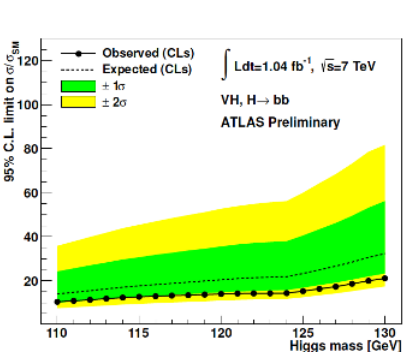
Fig. 2. Expected (dashed) and observed (solid line) exclusion limits for the ZH → llb ¯ b and WH → l ν b ¯ b channels combined, expressed as the ratio to the SM cross section, using the profile-likelihood method with CL s [3]. The green and yellow areas represent the 1s and 2s ranges of the expectation in the absence of a